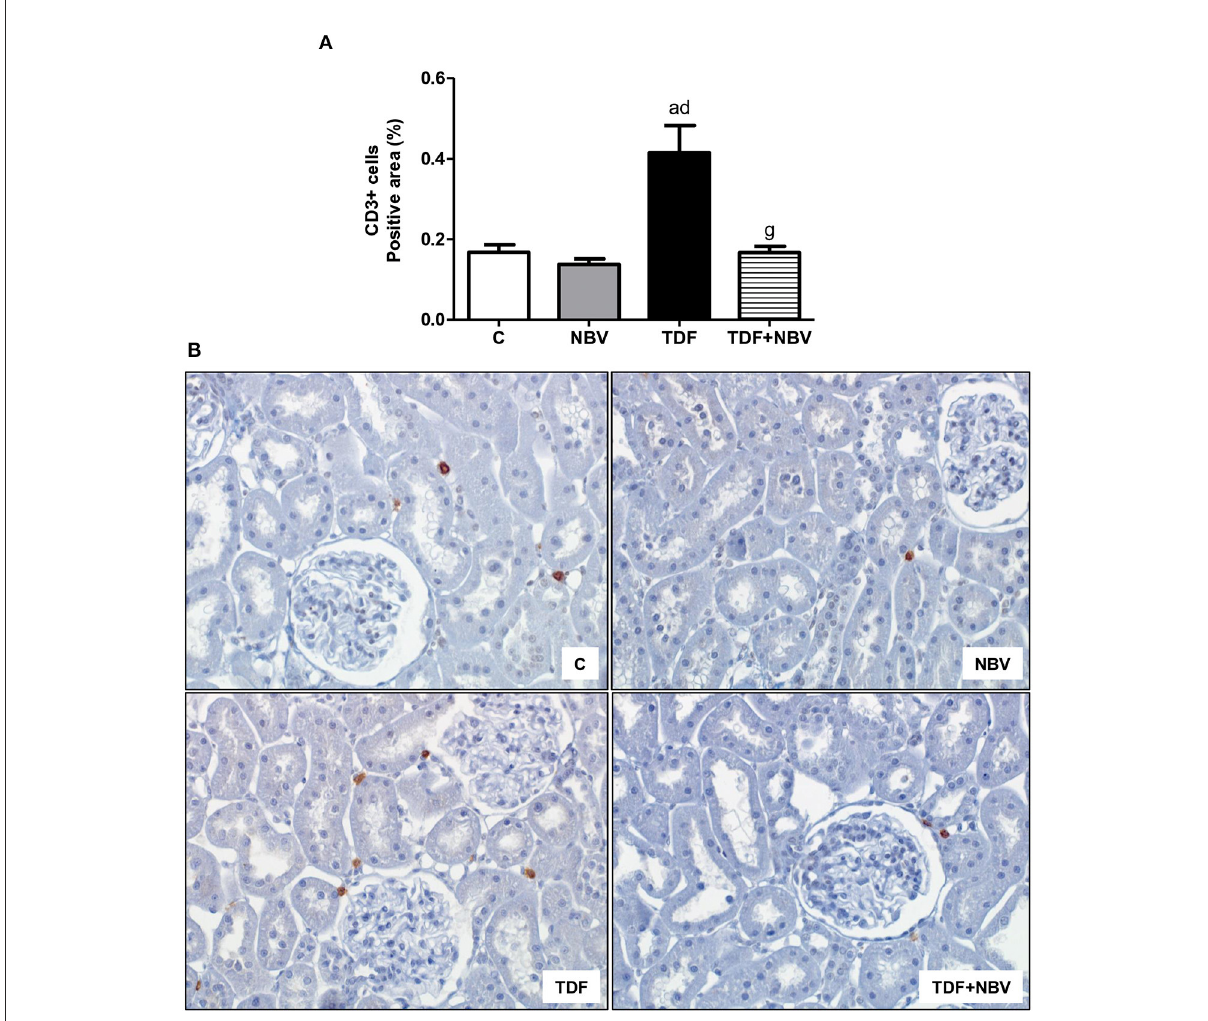
FIGURE5 Immunohistochemical analysis for CD3 + cells expression in rat kidney tissue. (A) Bar graph of CD3 positive cells expression values. (B) Representative photomicrographs of immunostaining for CD3 positive cells in the renal cortex from a C ( n = 7), NBV ( n = 7), TDF ( n = 8) and TDF + NBV ( n = 8) rat ( × 400). Values are means ± SEM. a p < 0.001 vs. C; d p < 0.001 vs. NBV; g p < 0.001 vs. TDF. C, control; NBV, Nebivolol; TDF,